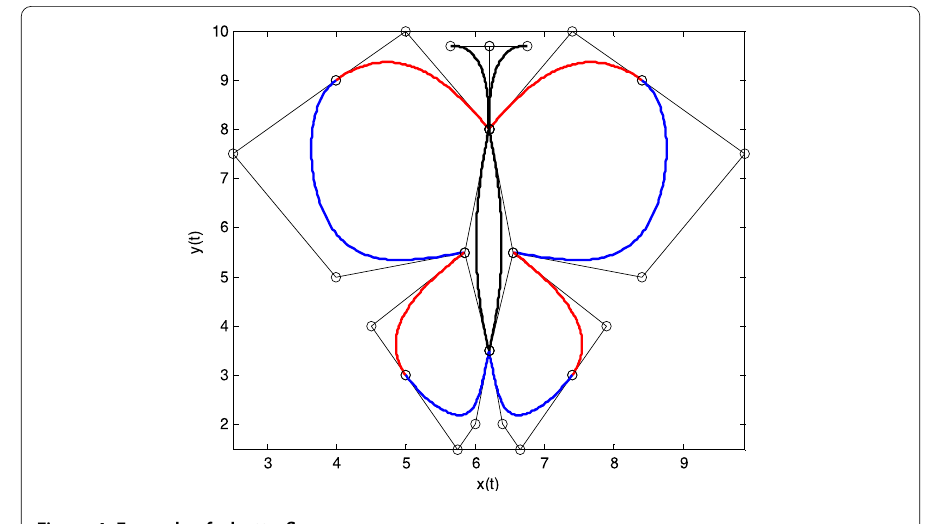
Figure 4 Example of a butterfly curve.